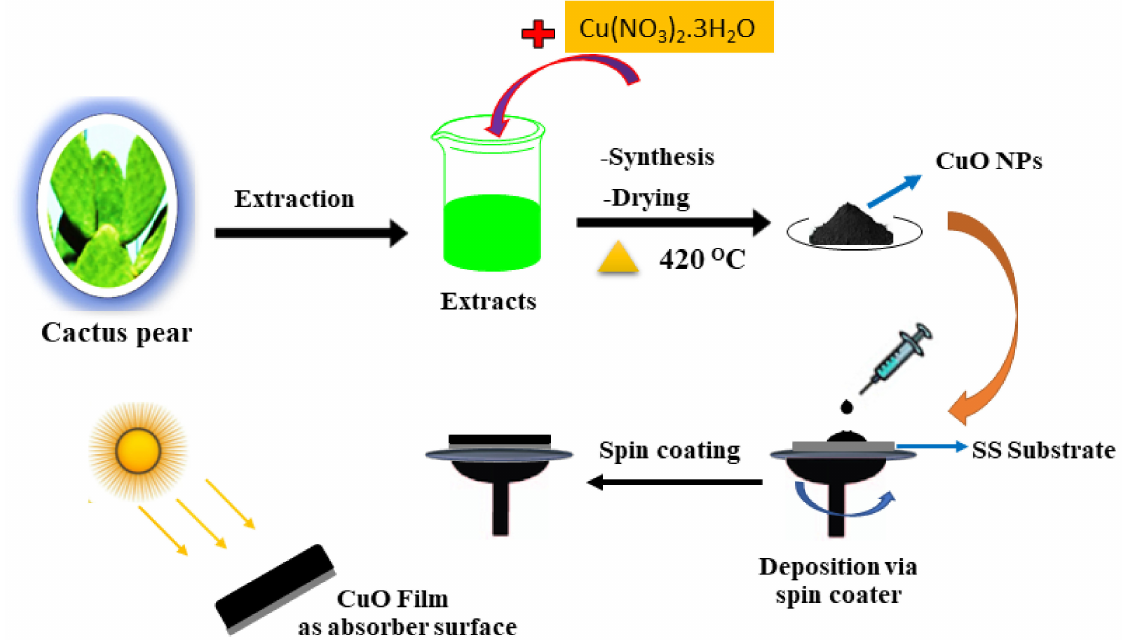
Figure 1. Schematic representation of extraction, biosynthesis, and deposition of CuO nanocoating as SSA